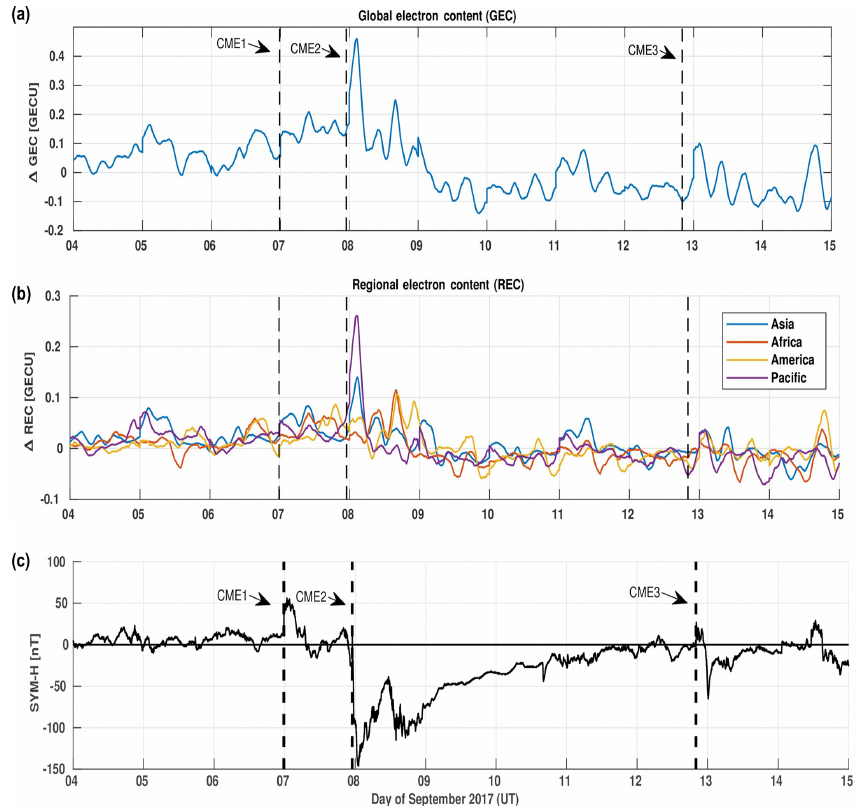
Figure 2. Variation of the global electron content (a) , the regional electron content (b) and the SYM-H index (c) during the geomagnetic storm of 4–14 September